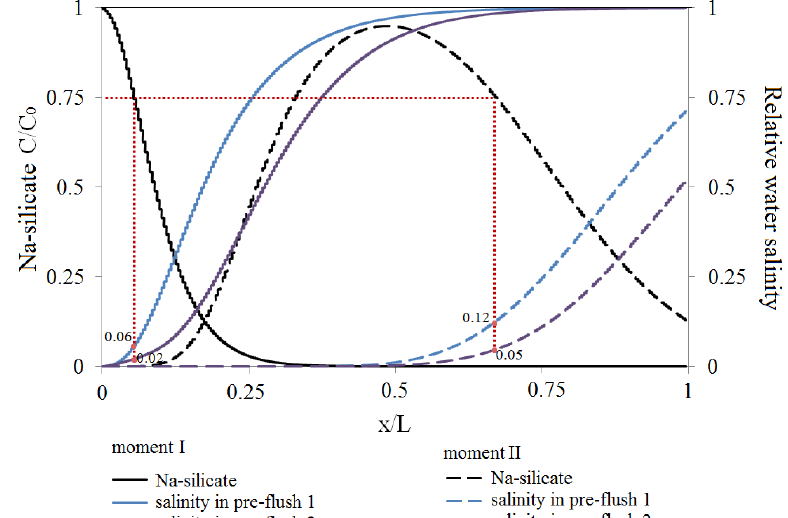
Figure 17. Concentration ratio of the Na-silicate slug and the relative water salinity as function of the normalized distance into the reservoir. The results are shown for two different LSW pre-flush Cases 1 and 2 and at two different intervals I and II during Na-silicate